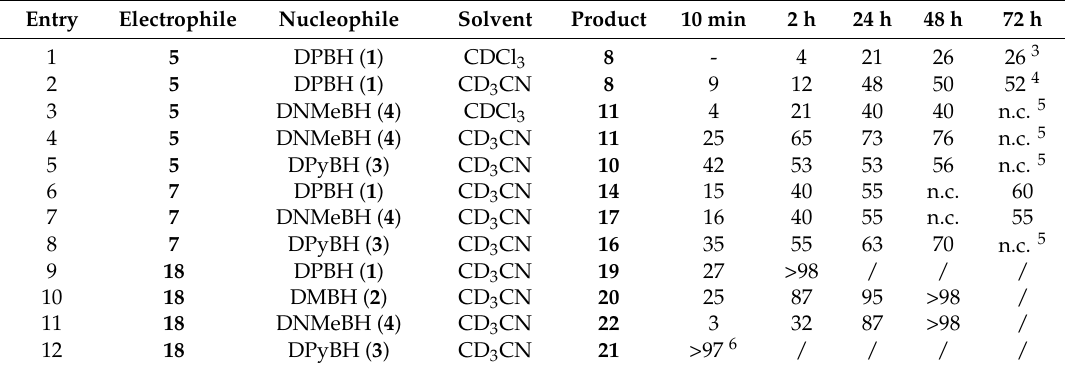
Table 1. Electrophile/nucleophile combinations 1 monitored via 1 H-NMR 2 .